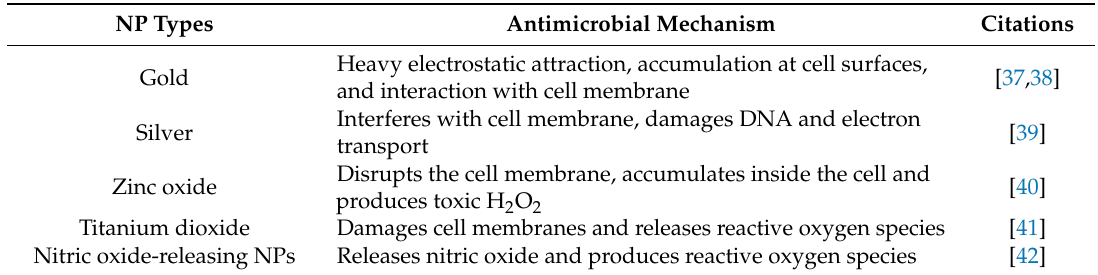
Table 1. Types of nanomaterials and their possible antimicrobial